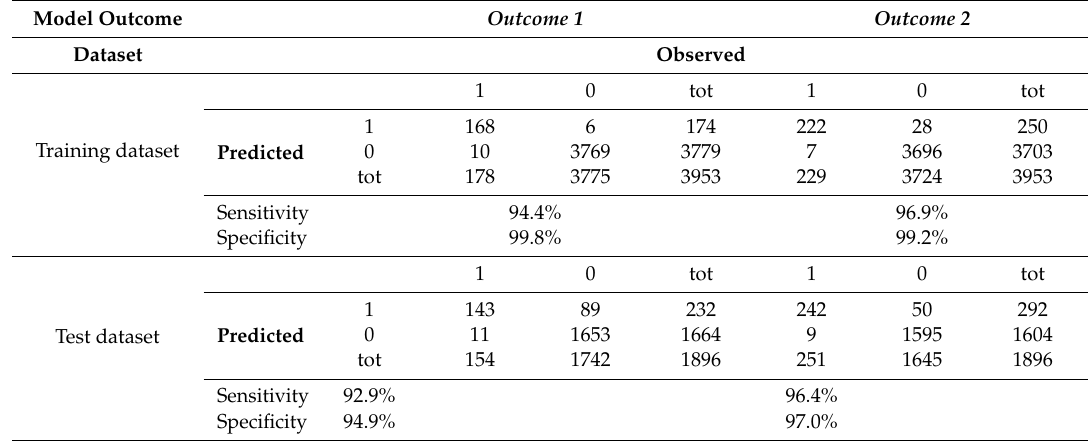
Table 4. Contingency tables for the discriminatory tests applied for internal validation (outcome 1 and outcome 2 on the training dataset), and eternal validation (outcome 1 and outcome 2 on the test